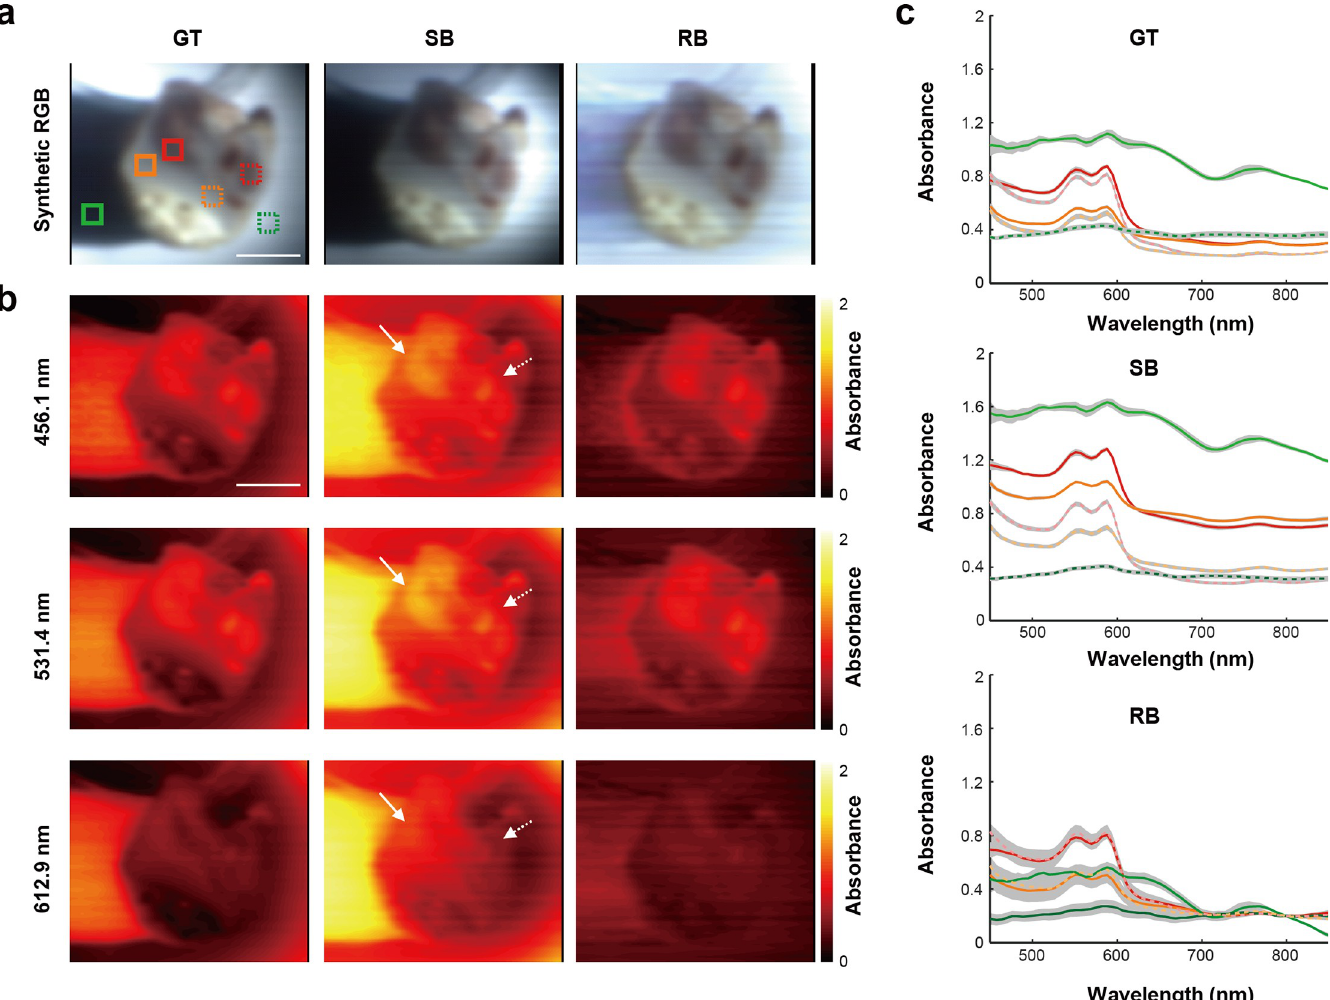
Fig 5. HSI data from a chicken tissue sample obtained using the RB method agrees well with the GT (a) Synthetic RGB images of the sample were created from hypercubes obtained by exploiting ground truth, single, and retrieved backgrounds. (b) Representative slice images from each hypercube (GT, SB and RB) were illustrated at three wavelengths (456.1, 531.4 and 612.9 nm). Solid and dashed arrows indicate anatomically similar structures in the sample. (c) Average absorbance of the hypercube reconstructed by using the GT, SB and RB methods within solid and dashed squares shown in (a) were obtained. Gray shaded area indicates the standard deviation. Scale bars: 1